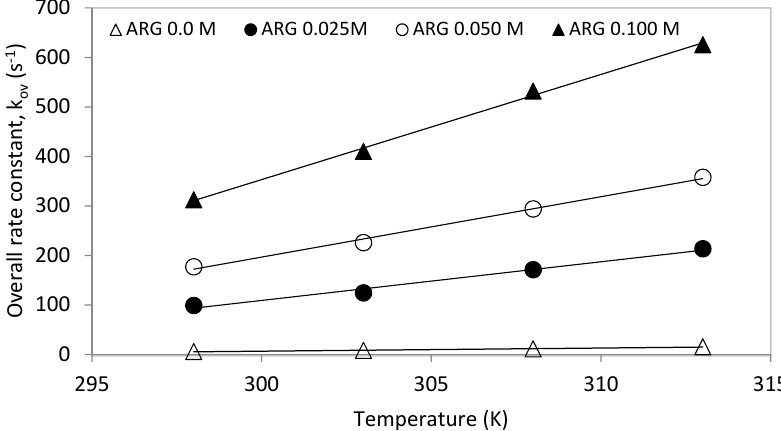
Figure 5. Rate constant, ‘k ov ’, vs. temperature for total 1 M solution.